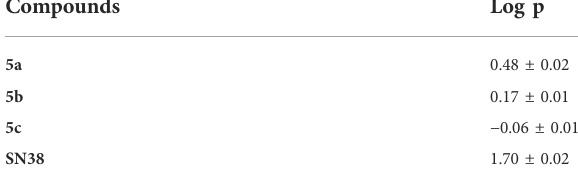
TABLE 1 Octanol-water partition coef fi cient of